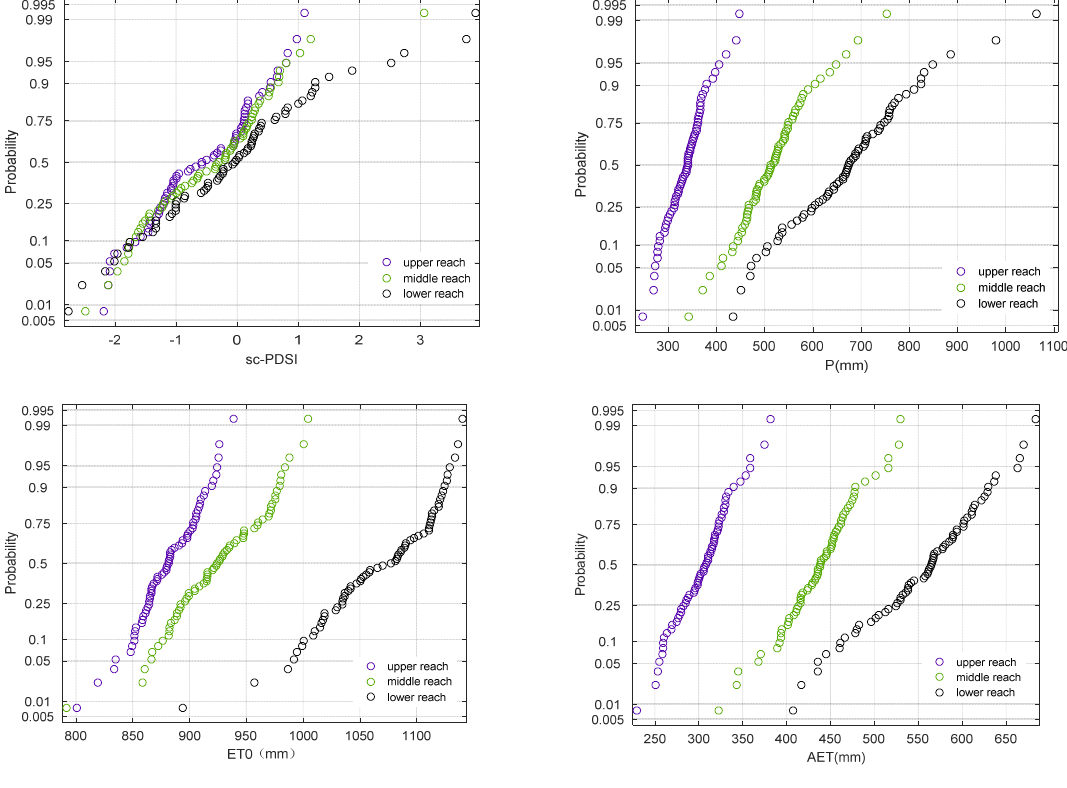
Figure 5. Probability plot of sc-PDSI, P, ET 0 , and AET in YRB on the yearly scale from 1951 to 2017.